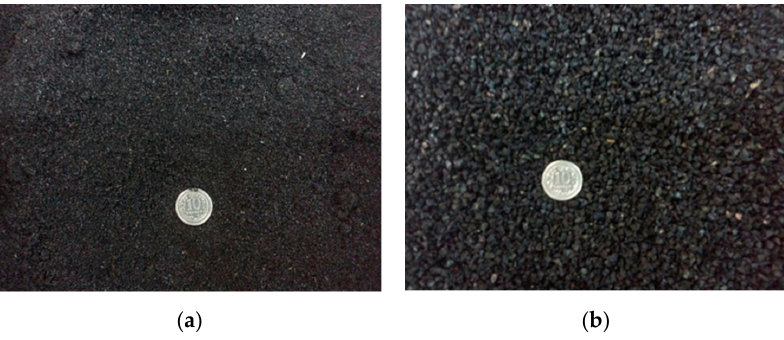
Figure 1. Rubber waste: ( a ) powder (P) 0–1 mm; ( b ) granulate (G) 1–5 mm. Table 2. Physical properties of the red clay (siCl/CH), kaolin (siCl/CL), powder (P), and granulate (G), based on the grain size distribution curves [30,53,64,70].